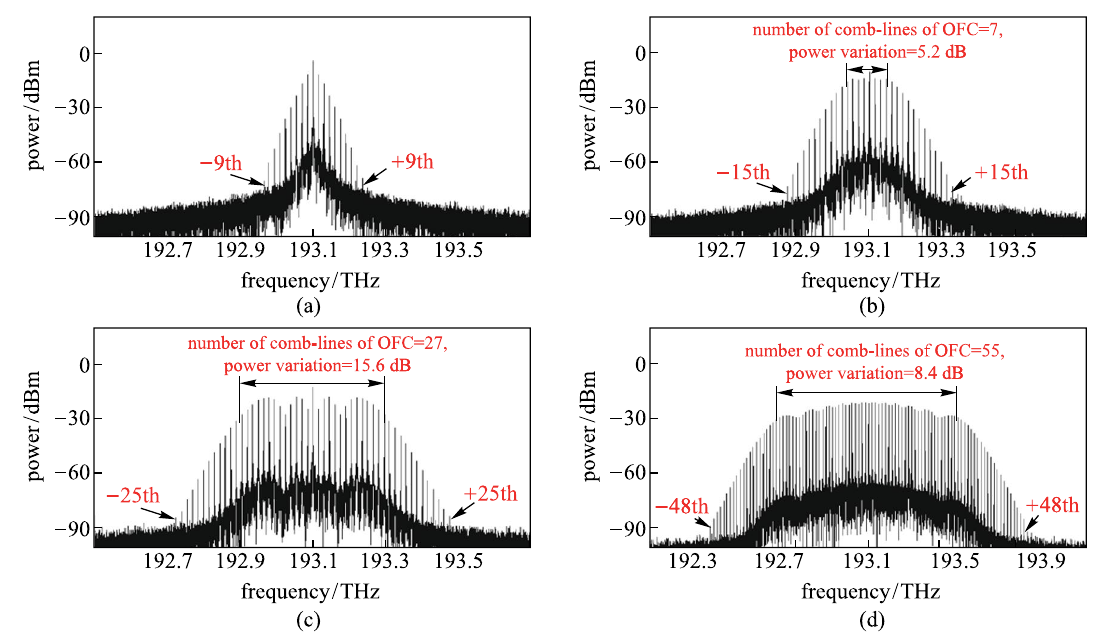
Fig. 5 Influence of the modulation index of EAM on the optical spectrum of the OFC. Modulation index of a 0.2, b 0.5, c 0.8, d 0.99 are consid- ered